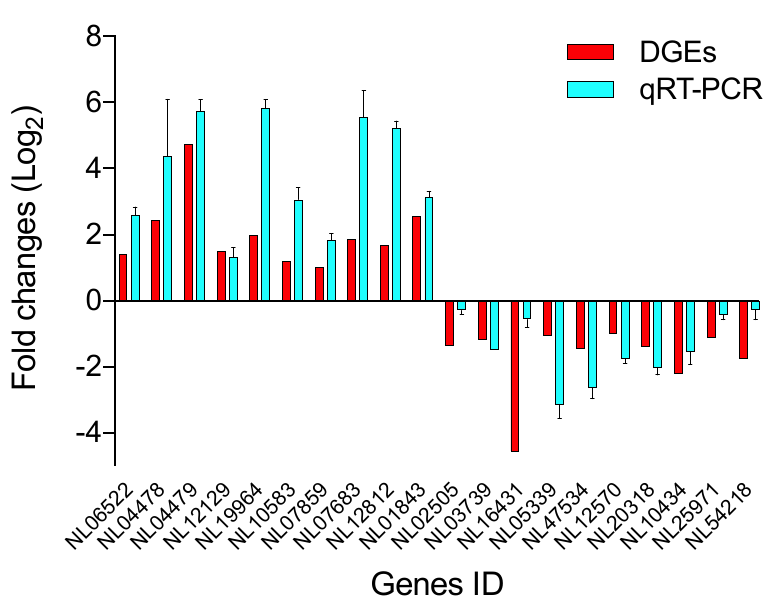
Figure 5. Transcriptomic validation by RT-qPCR and RNA-seq of the genes.